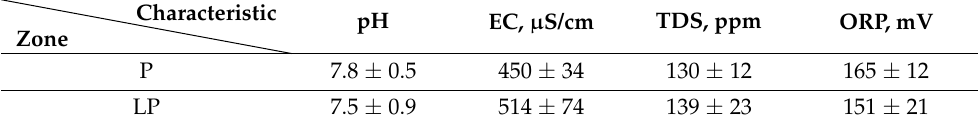
Table 4. Physicochemical characteristics of mulberry leaf.